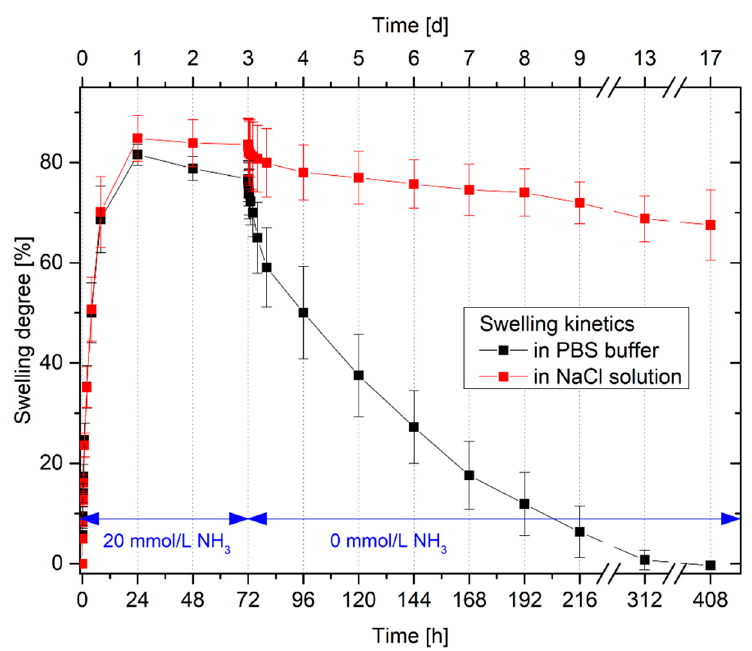
Figure 6. Swelling kinetics of poly(AAc ‐ co ‐ DMAEMA) (60 mol% AAc, 40 mol% DMAEMA) hydrogels in PBS buffer and in isotonic sodium chloride (NaCl) solution with 20 mmol/L ammonia and without ammonia, respectively.